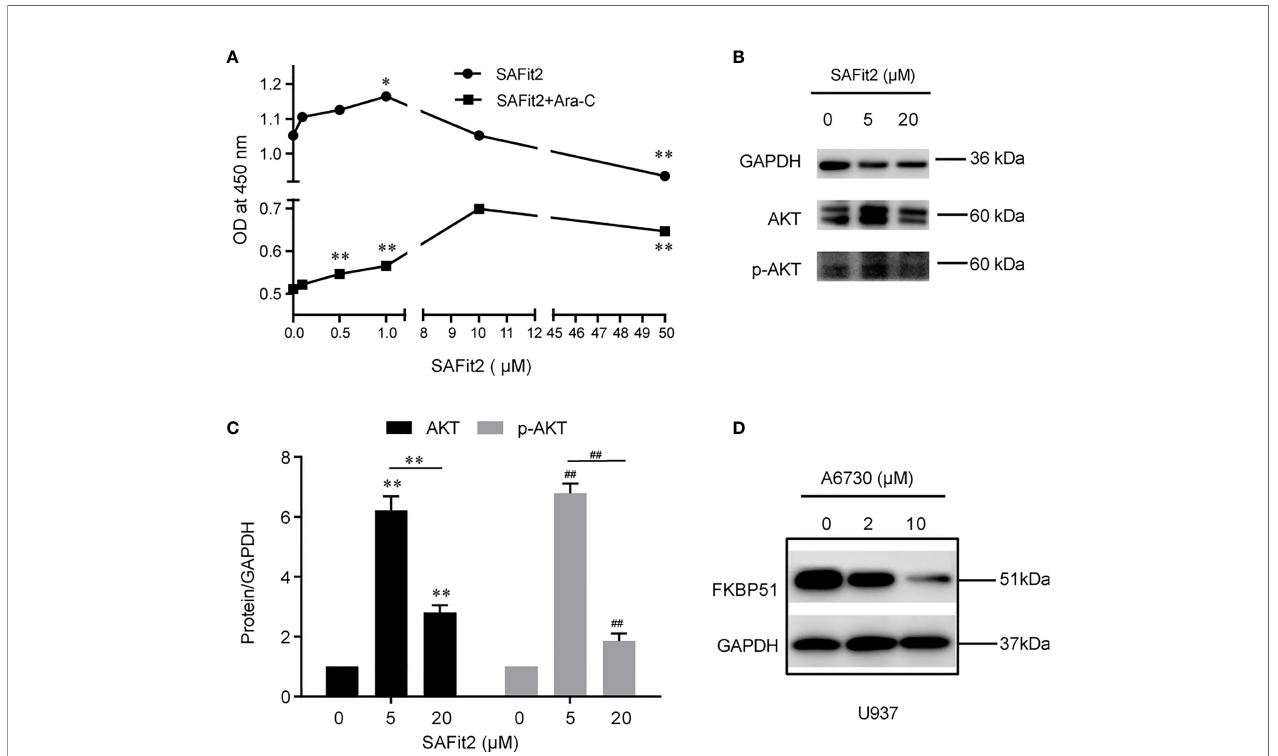
FIGURE 7 | The inhibitor of FKBP51 promote the proliferation of AML-M5 cells and inhibit their sensitivity to Ara-C. (A) After treatment with different concentrations of SAFit2 for 48 hours with or without 0.05 m M Ara-C, U937 cell proliferation was assessed by CCK-8 assay. (B, C) U937 cells were treated with different concentrations of SAFit2 (0, 5, and 10 m M) for 48 hours and then stimulated with LPS (1 m g/ml) for 15 minutes. The protein expression levels of AKT and p-AKT were detected by western blot. GAPDH was the internal control. (D) Western blot analysis of FKBP51 in U937 cells after treatment with different concentrations of A6730 (0, 5 and 10 m M) for 48 hours. Statistical differences from negative control cells are indicated by asterisks (*p < 0.05, ** and ## for p <